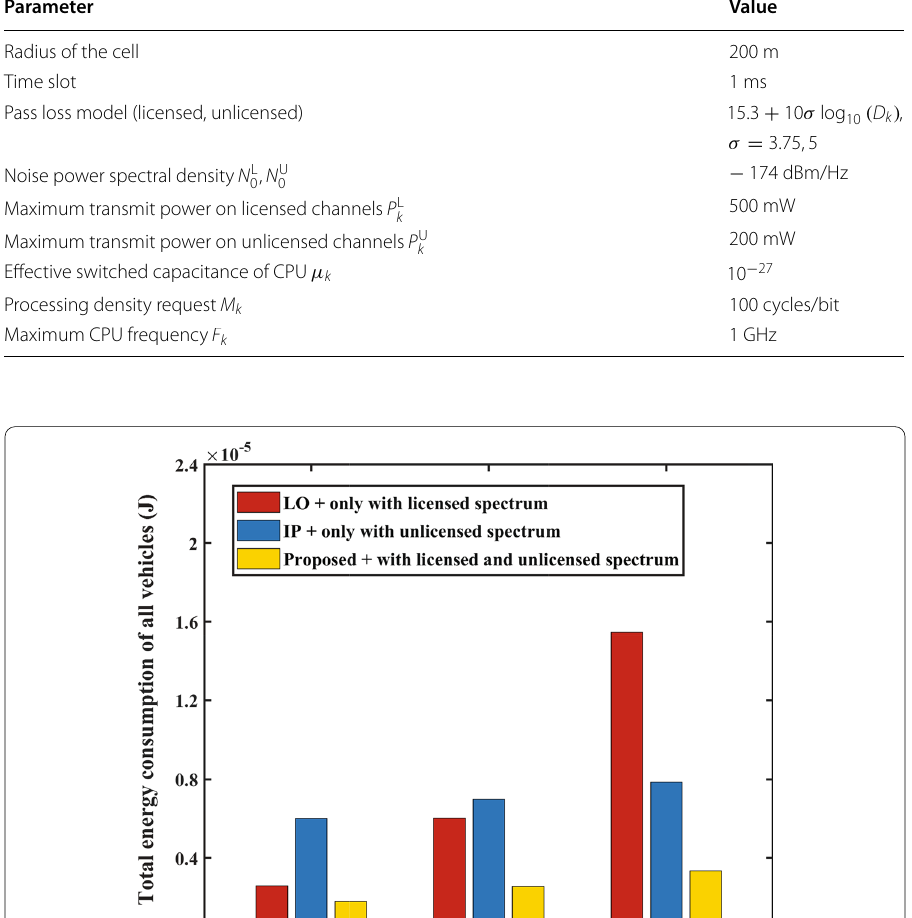
Fig. 2 The total energy consumption of all vehicles versus the number of vehicles, B L B